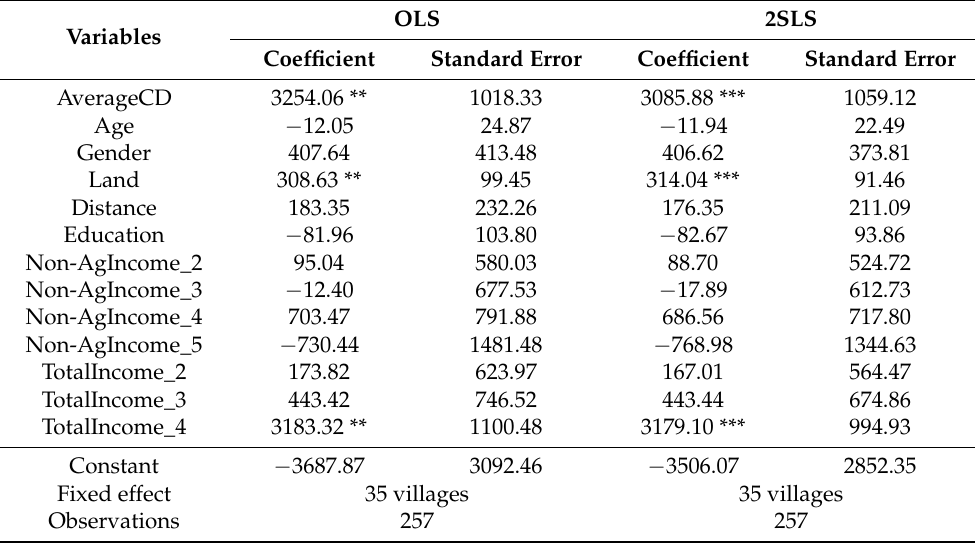
Table 3. Results of ordinary least squares (OLS) model and second IV regression result incorporating the average neighbor’s crop diversity (2SLS) showing how a farmer’s profit per year (a mean of 2018 and 2019) was affected by planted land size and the control factors.